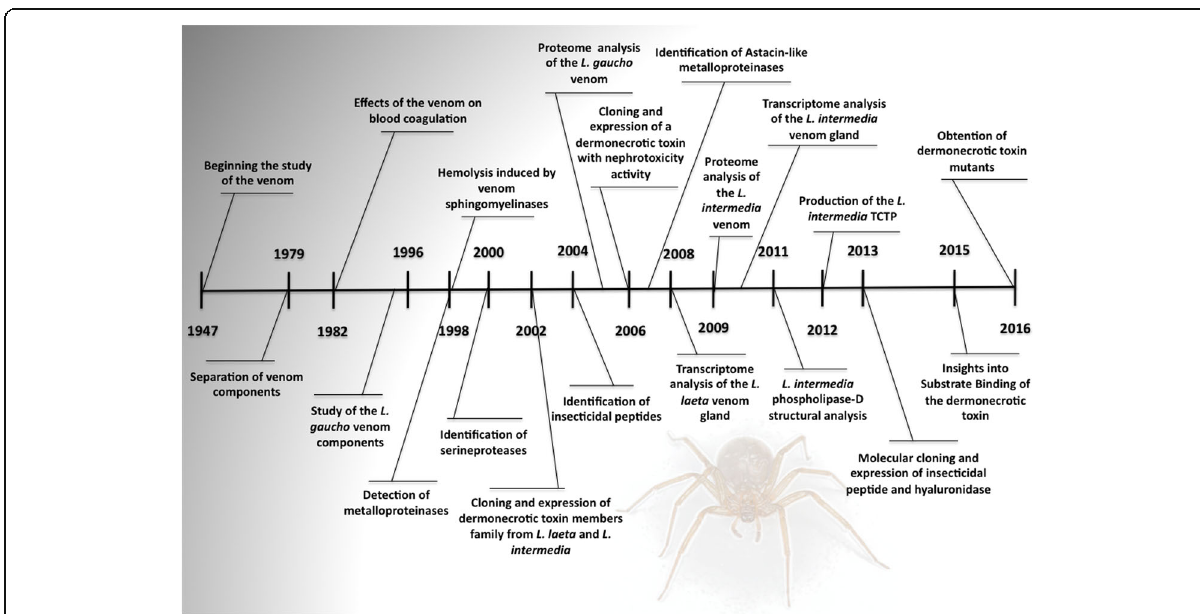
Fig. 1 Major historical evolution on the knowledge on brown spider venom. Main publications in toxinology on Loxosceles spiders